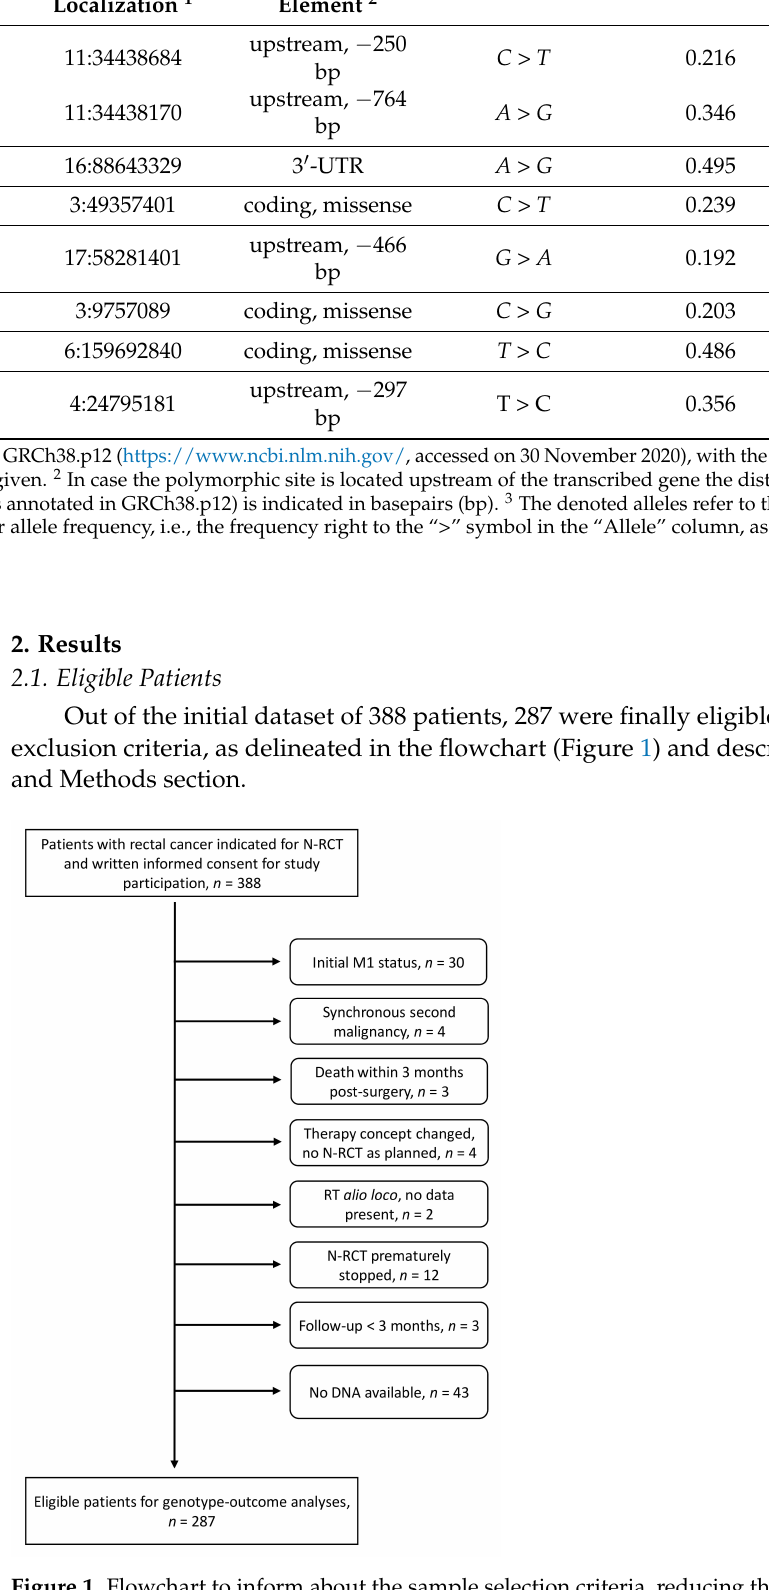
Figure 1. Flowchart to inform about the sample selection criteria, reducing the initial number of 388 patients to a final 287 eligible for assessment of genotypes in relation to clinical